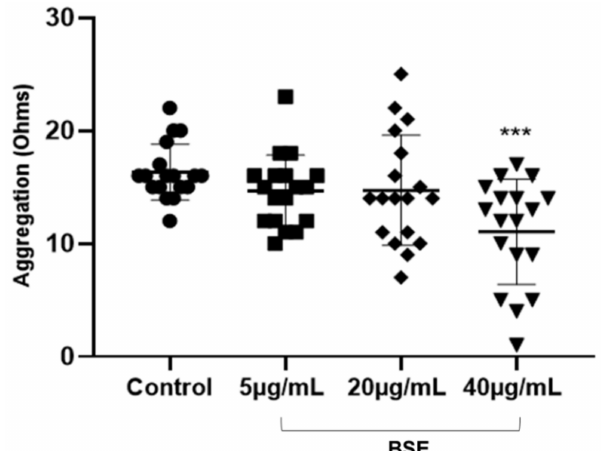
Figure 1. The e ff ect of varying concentrations of BSE on collagen-induced aggregation. BSE at 40 µ g / mL significantly reduced platelet aggregation (5.3 ± 1.3; p value = 0.0004). BSE at 5 µ g / mL and 20 µ g / mL did not reduce platelet aggregation when compared to control ( p value > 0.1). N = 18 and data is represented in aggregation (Ohms) versus BSE concentrations. *** signifies statistical significance p < 0.001 compared to control. Error bars expressed as mean ± SD.